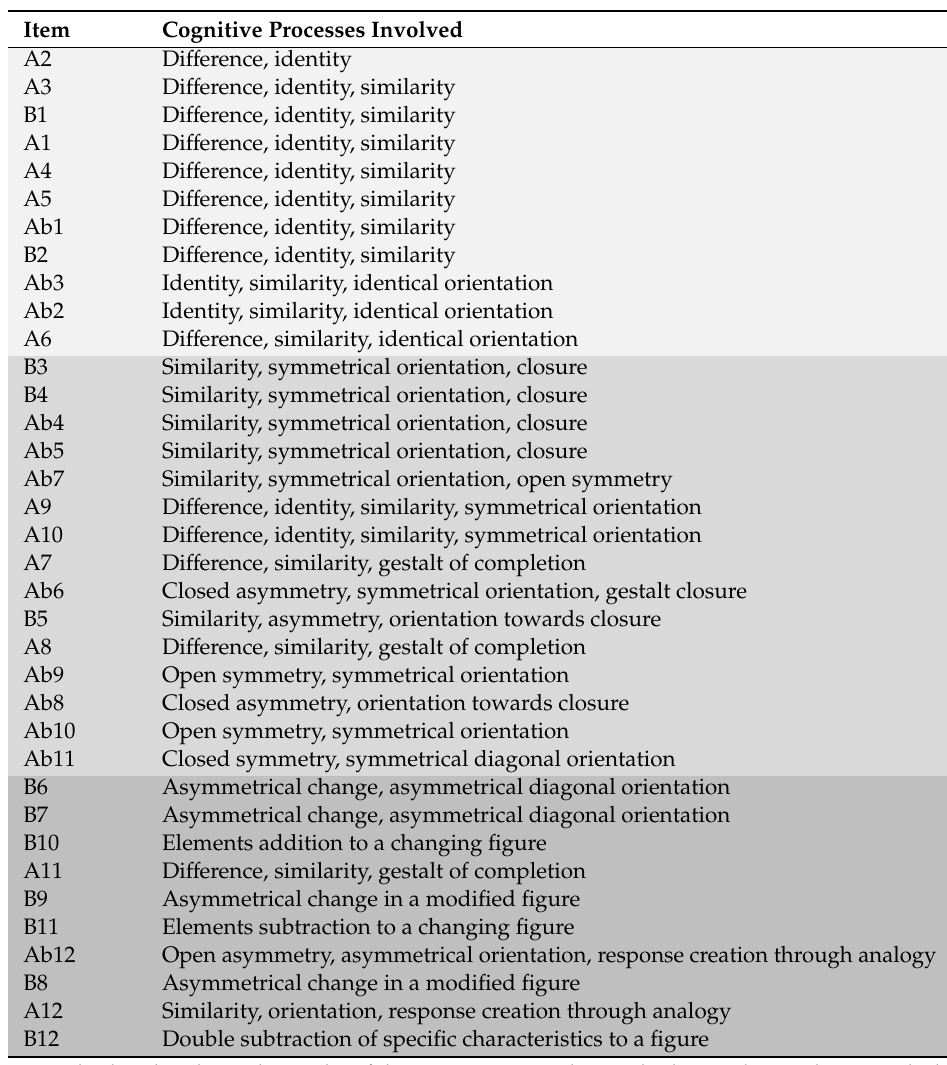
Table 1. Qualitative analysis of items: cognitive processes involved in each Raven’s Coloured Progressive Matrices (RCPM)